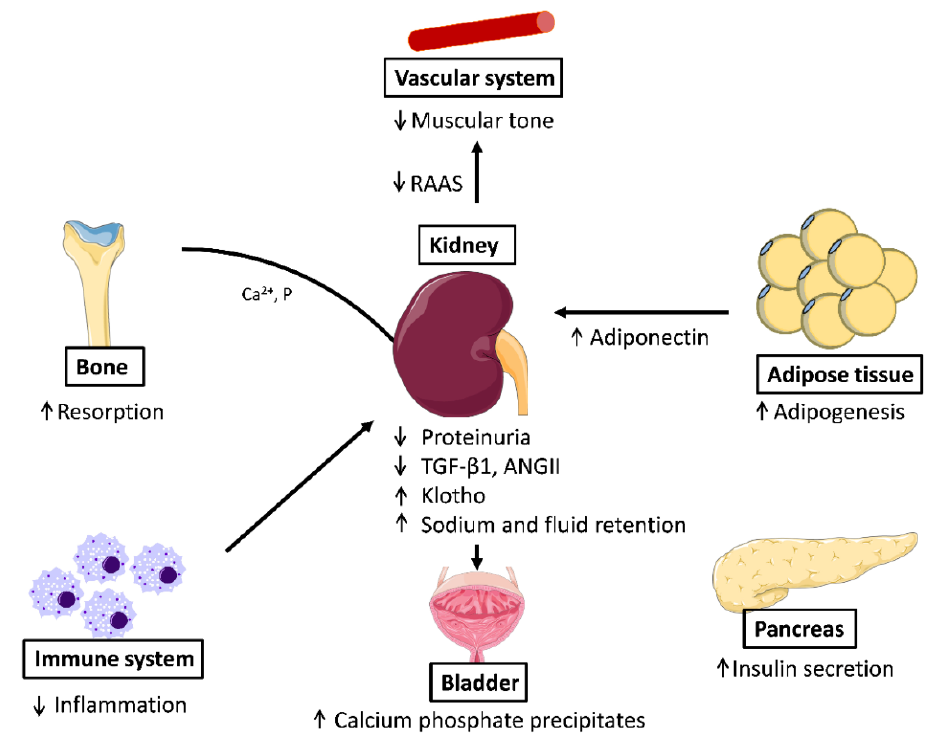
Figure 2. Effects of PPARγ activation in different systems: In the vascular system, PPARγ decreases arterial pressure, relaxes muscular tone, and downregulates RAAS; in adipose tissue, the activation of PPARγ promotes adipogenesis; in β-cells it increases insulin secretion; PPARγ is also anti-inflammatory and from the bone resorption is produced accompanied of release of calcium and phosphate that form stones in the bladder. ANG-II: Angiotensin II; RAAS, Renin Angiotensin Aldosterone System; TGF-β1, transforming growth factor beta 1.